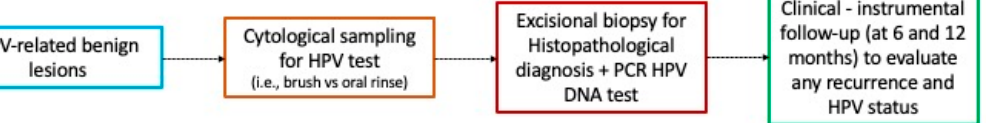
Figure 1. Oral lesions traditionally associated with LR-HPV: ( a ) wart on upper lips; ( b ) papilloma on ventral surface of tongue; ( c ) condyloma on soft palate; ( d ) condyloma on ventral surface of tongue.